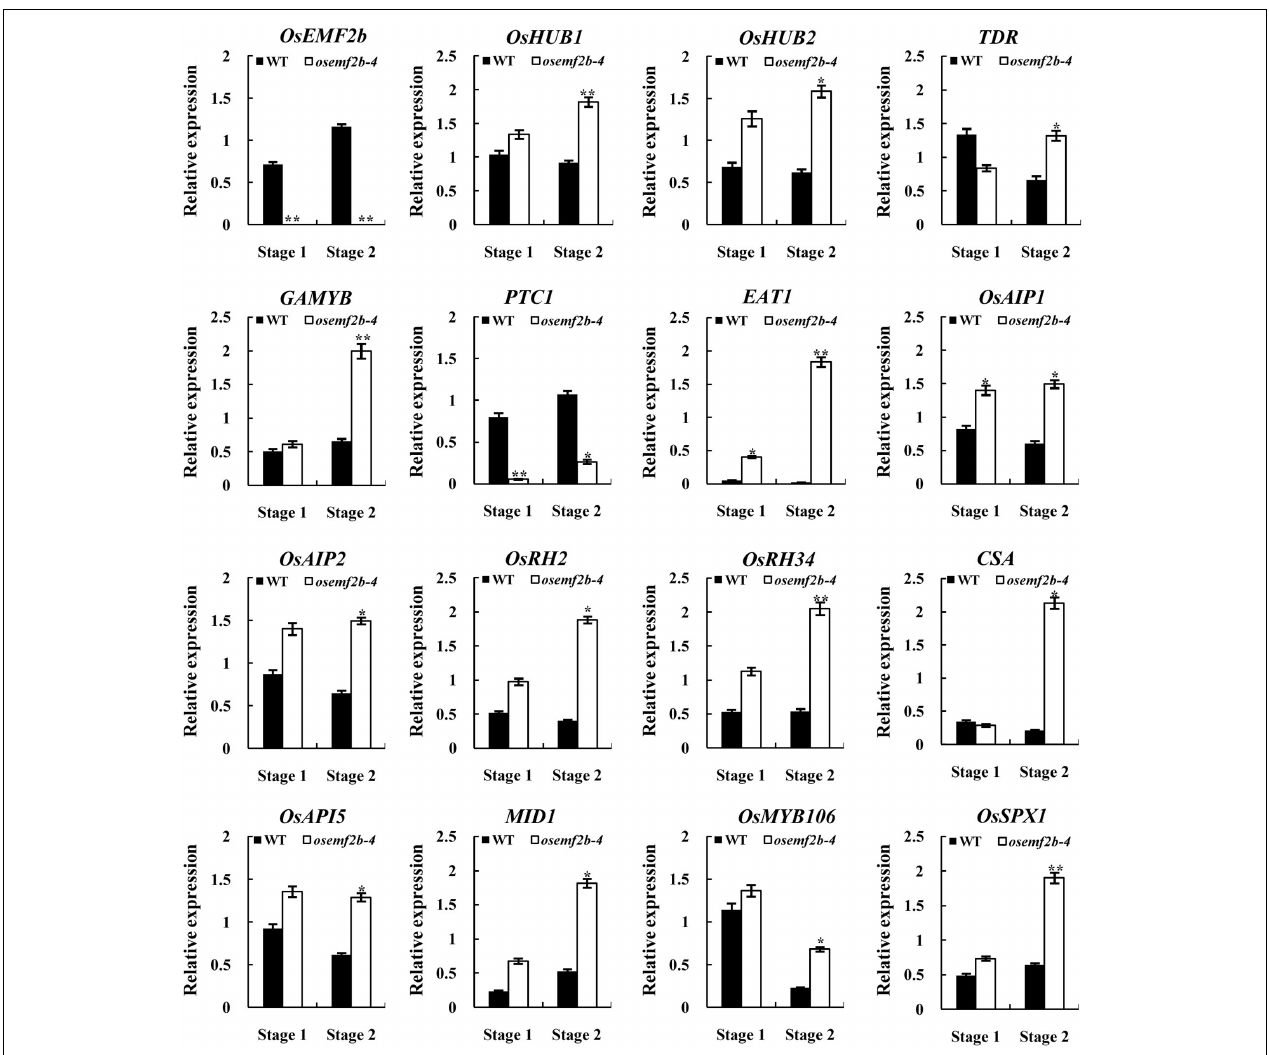
FIGURE 6 | RT-qPCR expression analysis of OsEMF2b and genes involved in rice anther and pollen development in the inflorescence of the wild type and osemf2b-4 plants. Stage 1 and stage 2 represent meiosis stage and young microspore stage, respectively. The ubiquitin gene was used as an internal control. Each data point is the average of three biological repeats. Error bars indicate SD. ∗ , ∗∗ indicate significant difference by Student’s t -test ( P ≤ 0.05 and